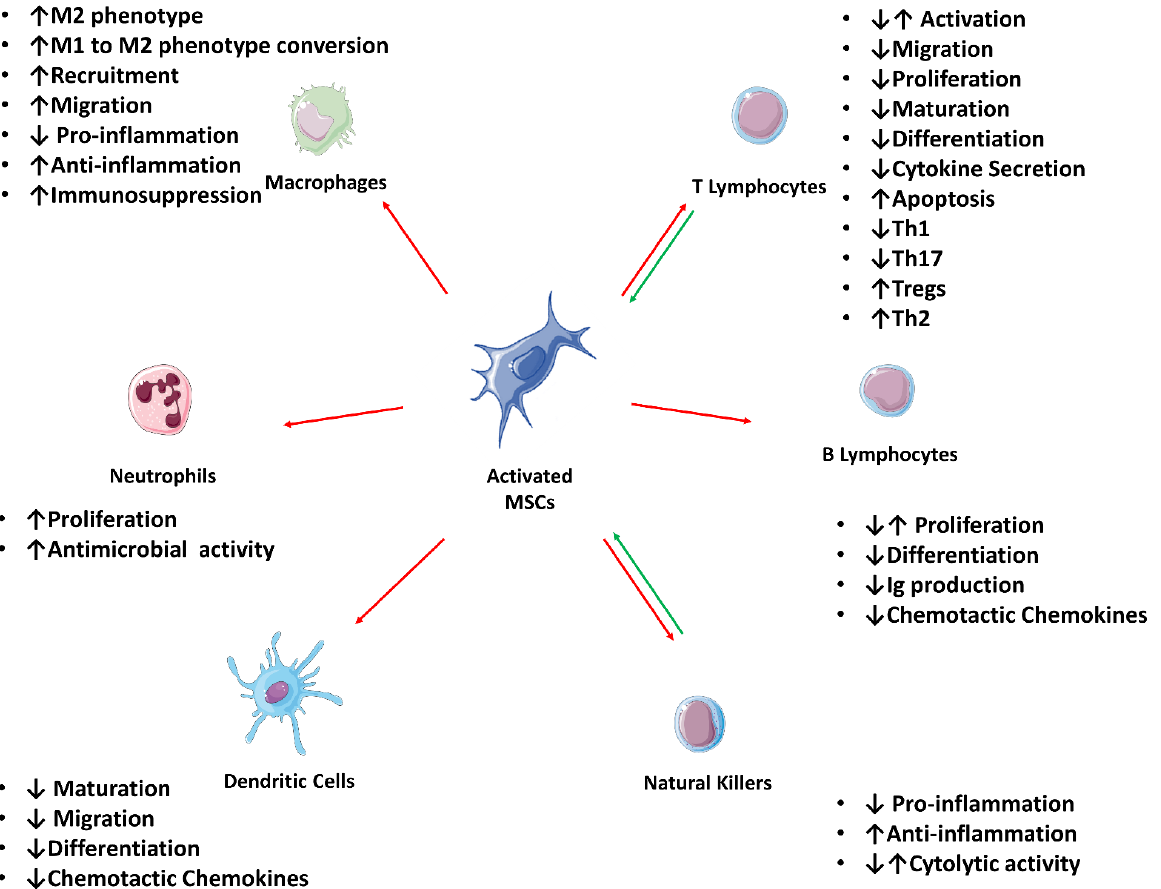
Figure 2. Functional and immunomodulatory influences of MSCs on cells of the Innate and Adaptive Immune System. Red Arrows—Action of MSCs on Immune System cells. Green Arrows—Action of Immune System Cells on MSCs, with activation and retroactive stimulation. (Adapted with permission from Servier Medical Art, licensed under a Creative Common Attribution 3.0 Generic Licence. https://smart.servier.com/. Accessed on January 5, 2022).